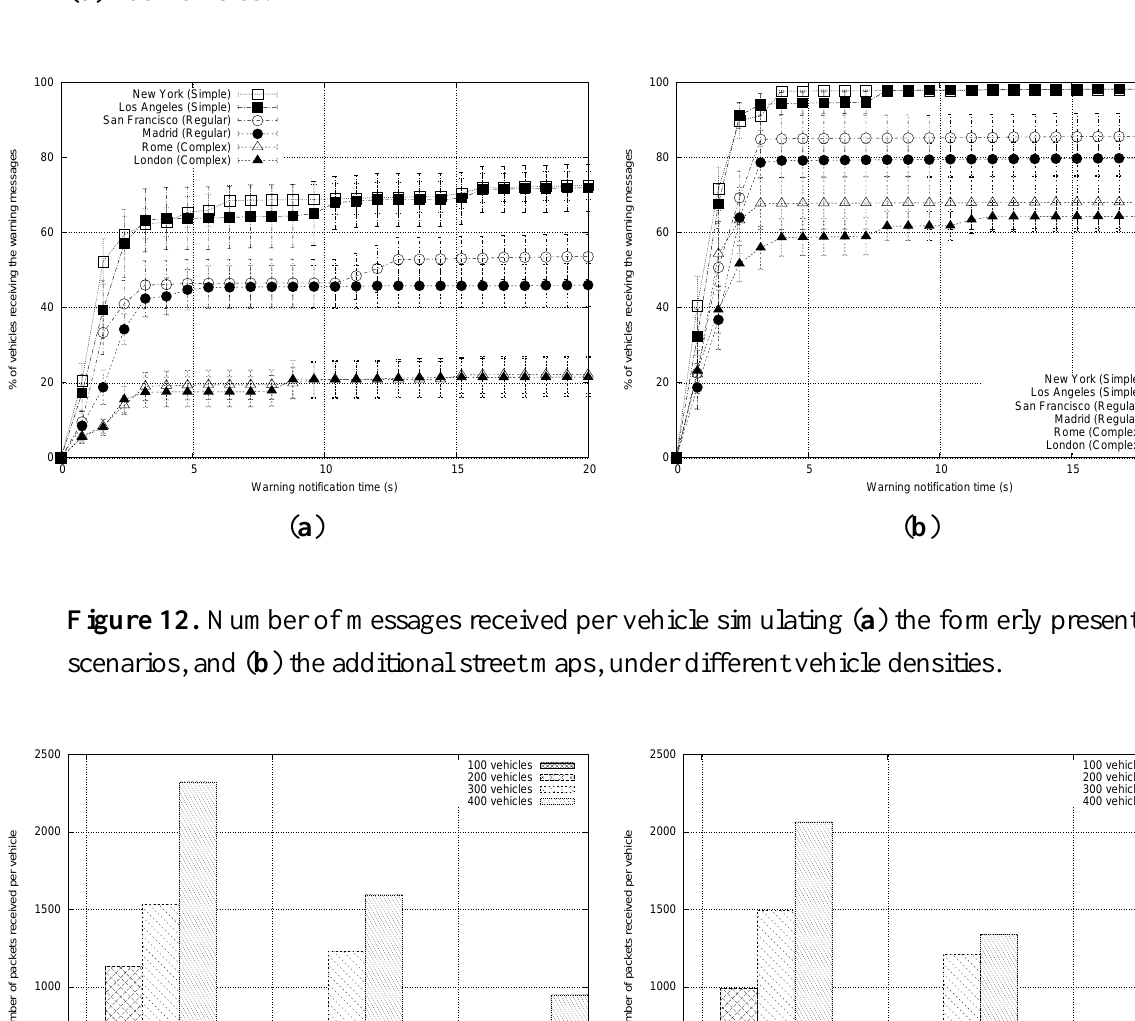
Figure 11. Warning notification time in different scenarios simulating ( a ) 100 vehicles and ( b ) 400 vehicles.